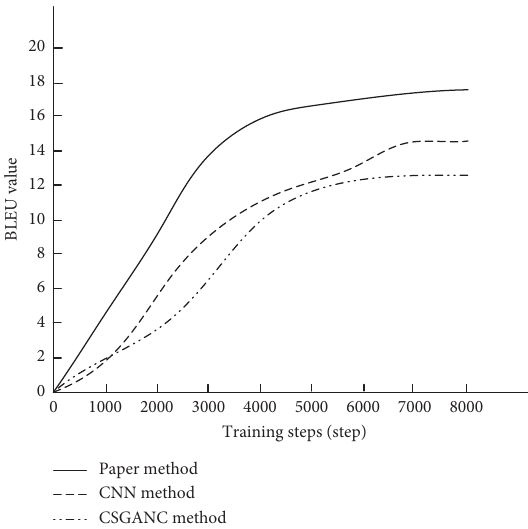
Figure 2: Comparison of BLEU values of different methods.